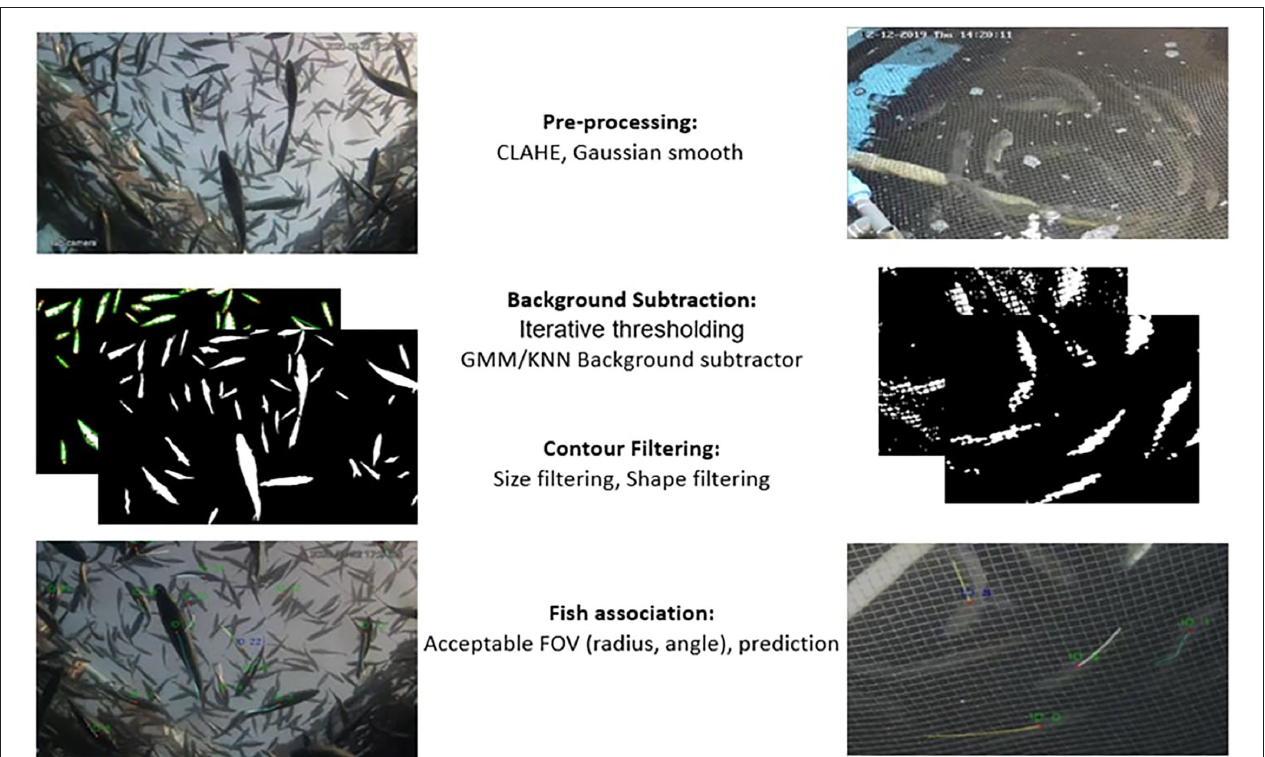
FIGURE 2 | Schematic representation of the steps followed for the extraction of individual trajectories.